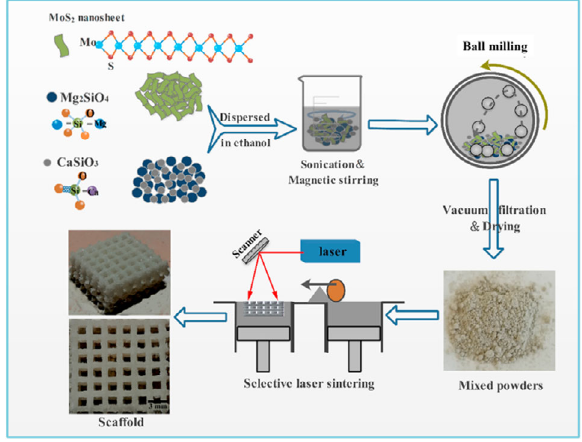
Fig. 10 Fabrication process of a bioceramic scaffold incorporating MoS 2 . Reproduced with permission from Ref. [15], © Elsevier Ltd.